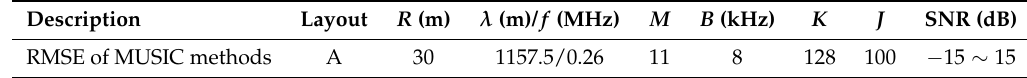
Table 2. Parameter setting in MP-MUSIC